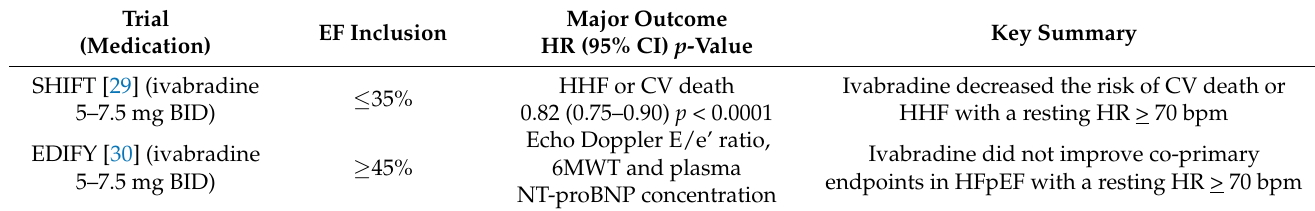
Table 6. Ivabradine heart failure